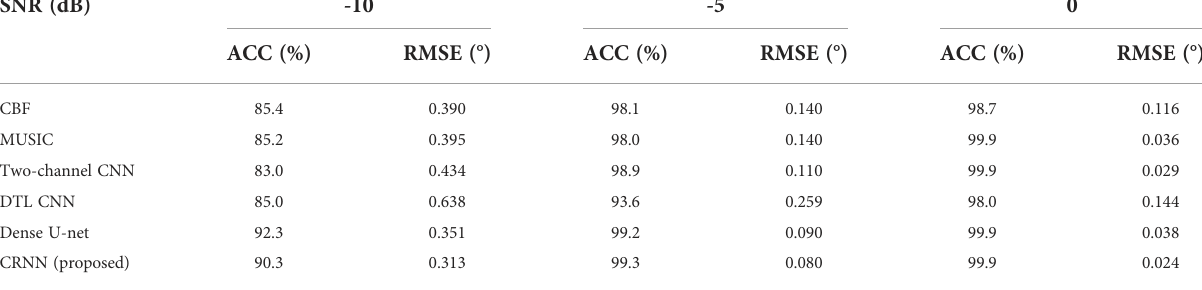
TABLE 2 Performance comparison of different methods.